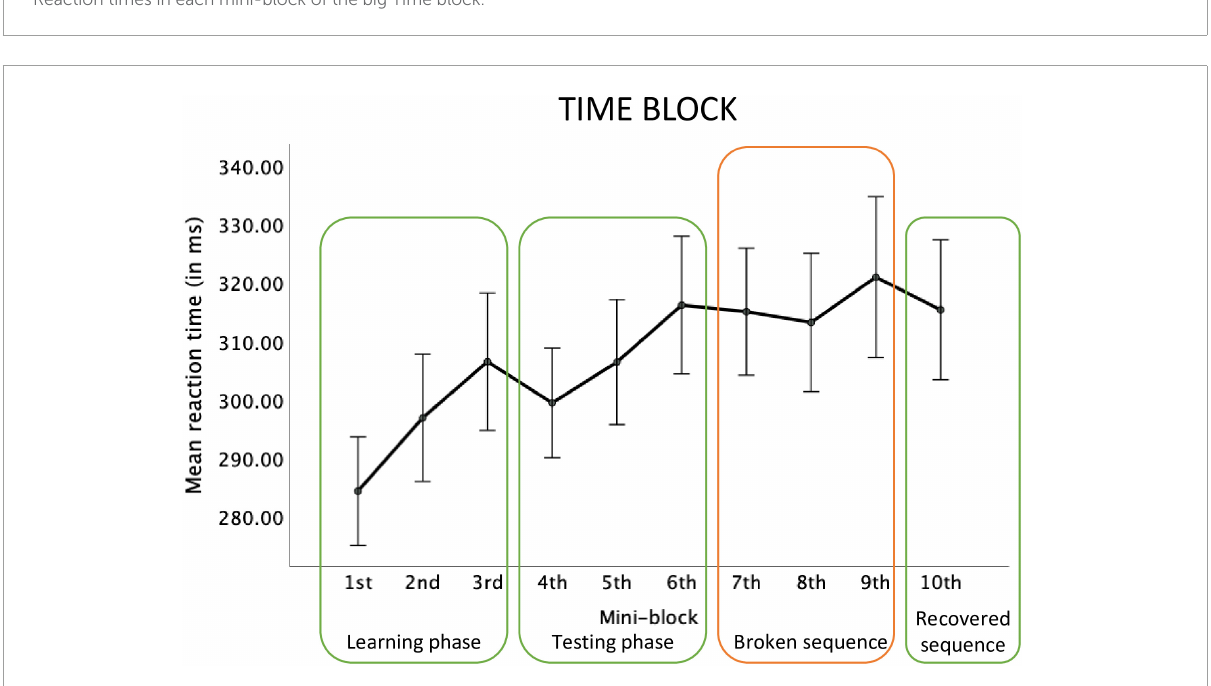
FIGURE5 Reaction times in each mini-block of the big Space-Time block.